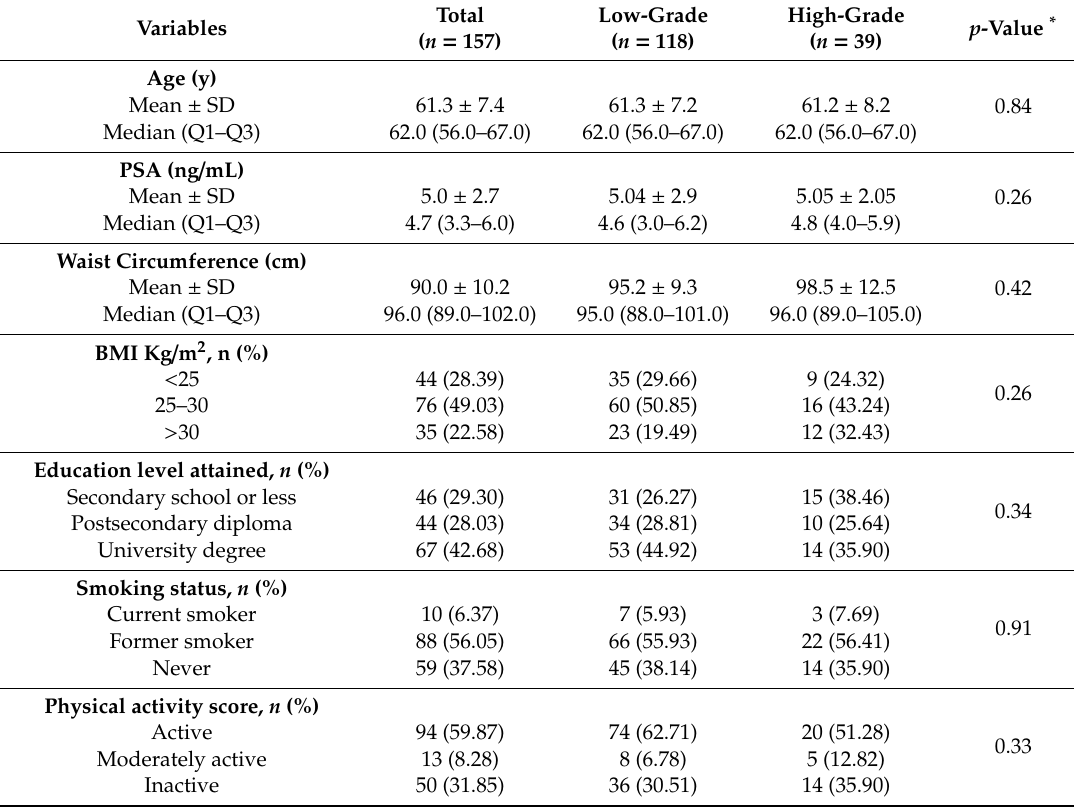
Table 1. Characteristics of the study subjects at the first repeat biopsy